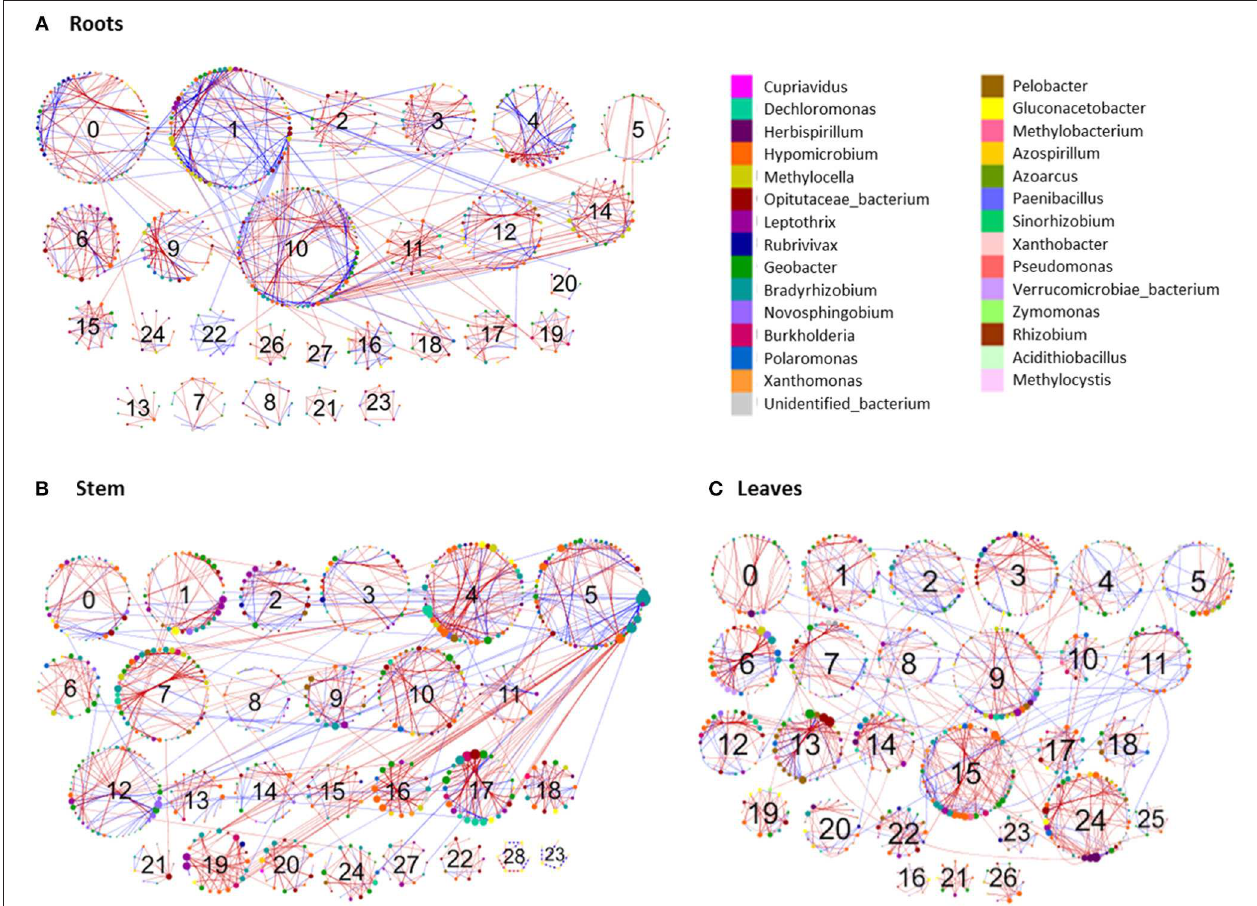
FIGURE 6 | Comparison of diazotroph community networks associated with different plant parts of the three perennial grass species. Circles represent nodes whose size indicates connectivity; node color represents taxonomy at the genus level. Edges indicate co-occurrence between nodes colored either blue for positive or red for negative. Each circular grouping is a module, modules containing at least five nodes are identified by their assigned